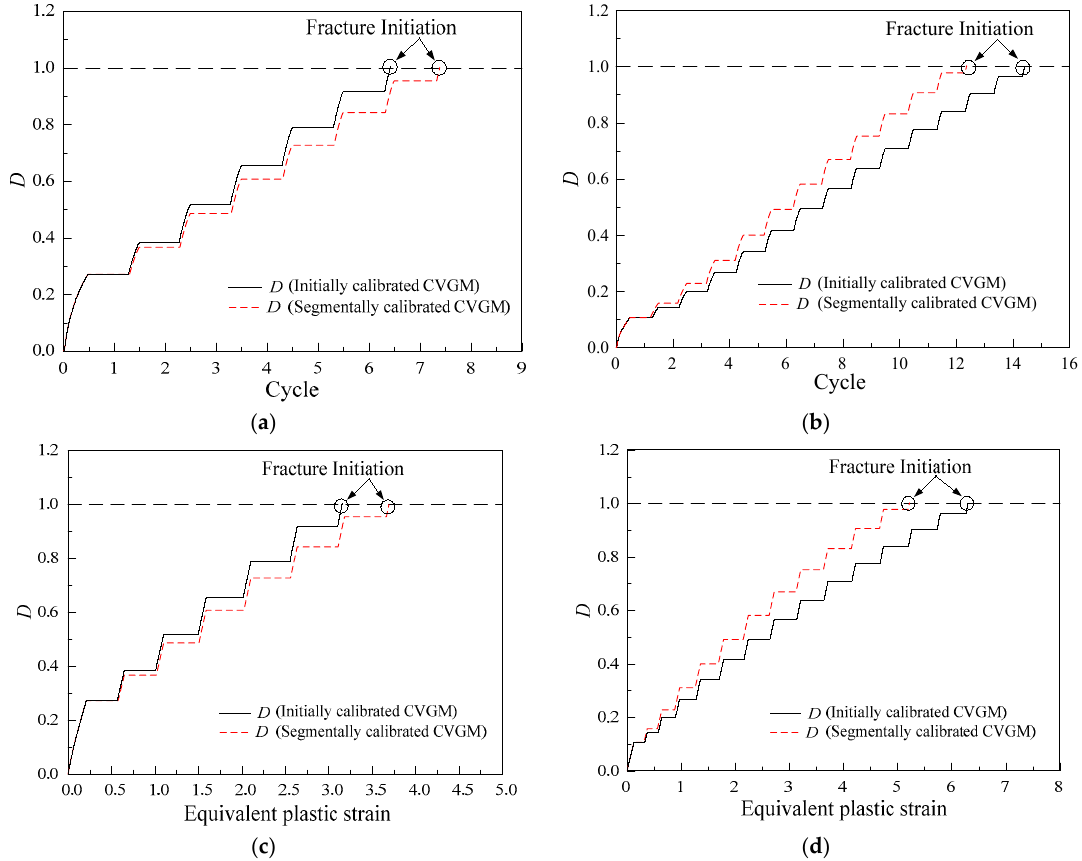
Figure 12. Evolution of damage index Figure: ( a ) BMC-19; ( b ) BMC-28; ( c ) BMC-19; ( d ) BMC-28.